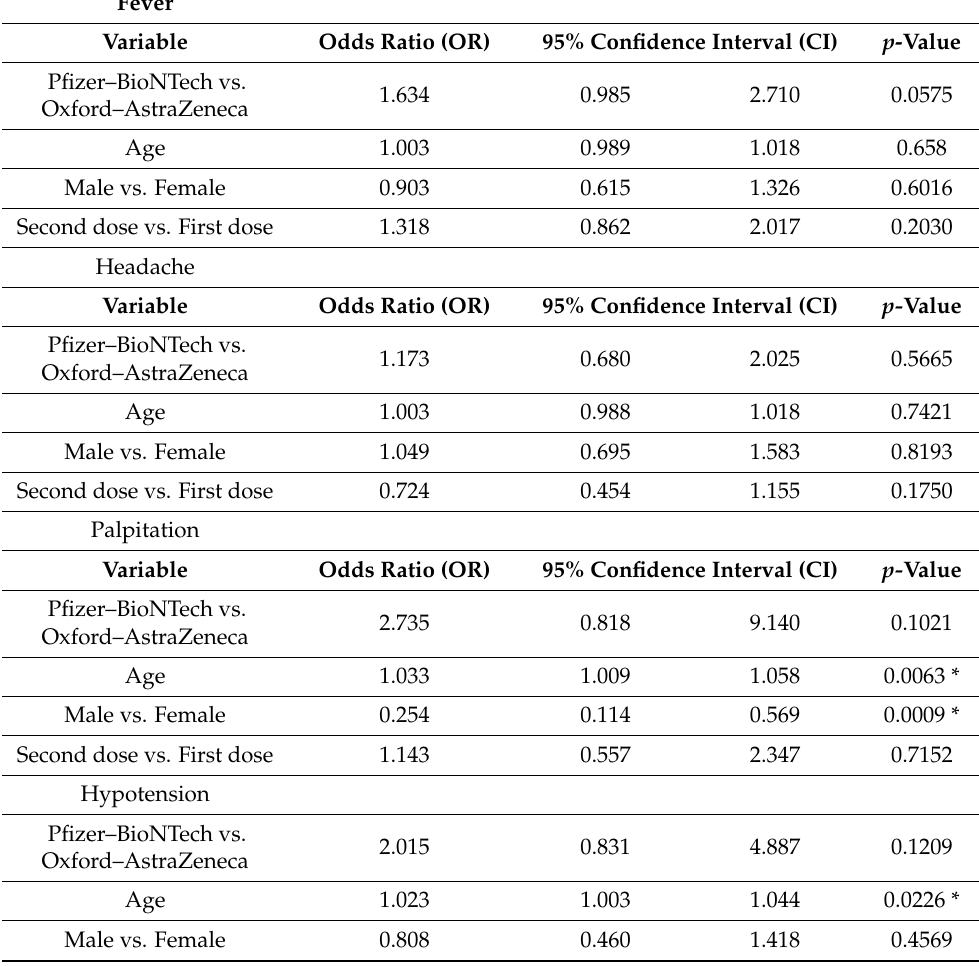
Table 4. Univariate logistic regressions for the association between the most commonly reported vaccine side effects (fever, headache, palpitation, hypotension, diarrhea, loss of smell or taste, mus- culoskeletal pain, and irregular menstrual periods) and vaccine type, age, gender, and number of vaccine